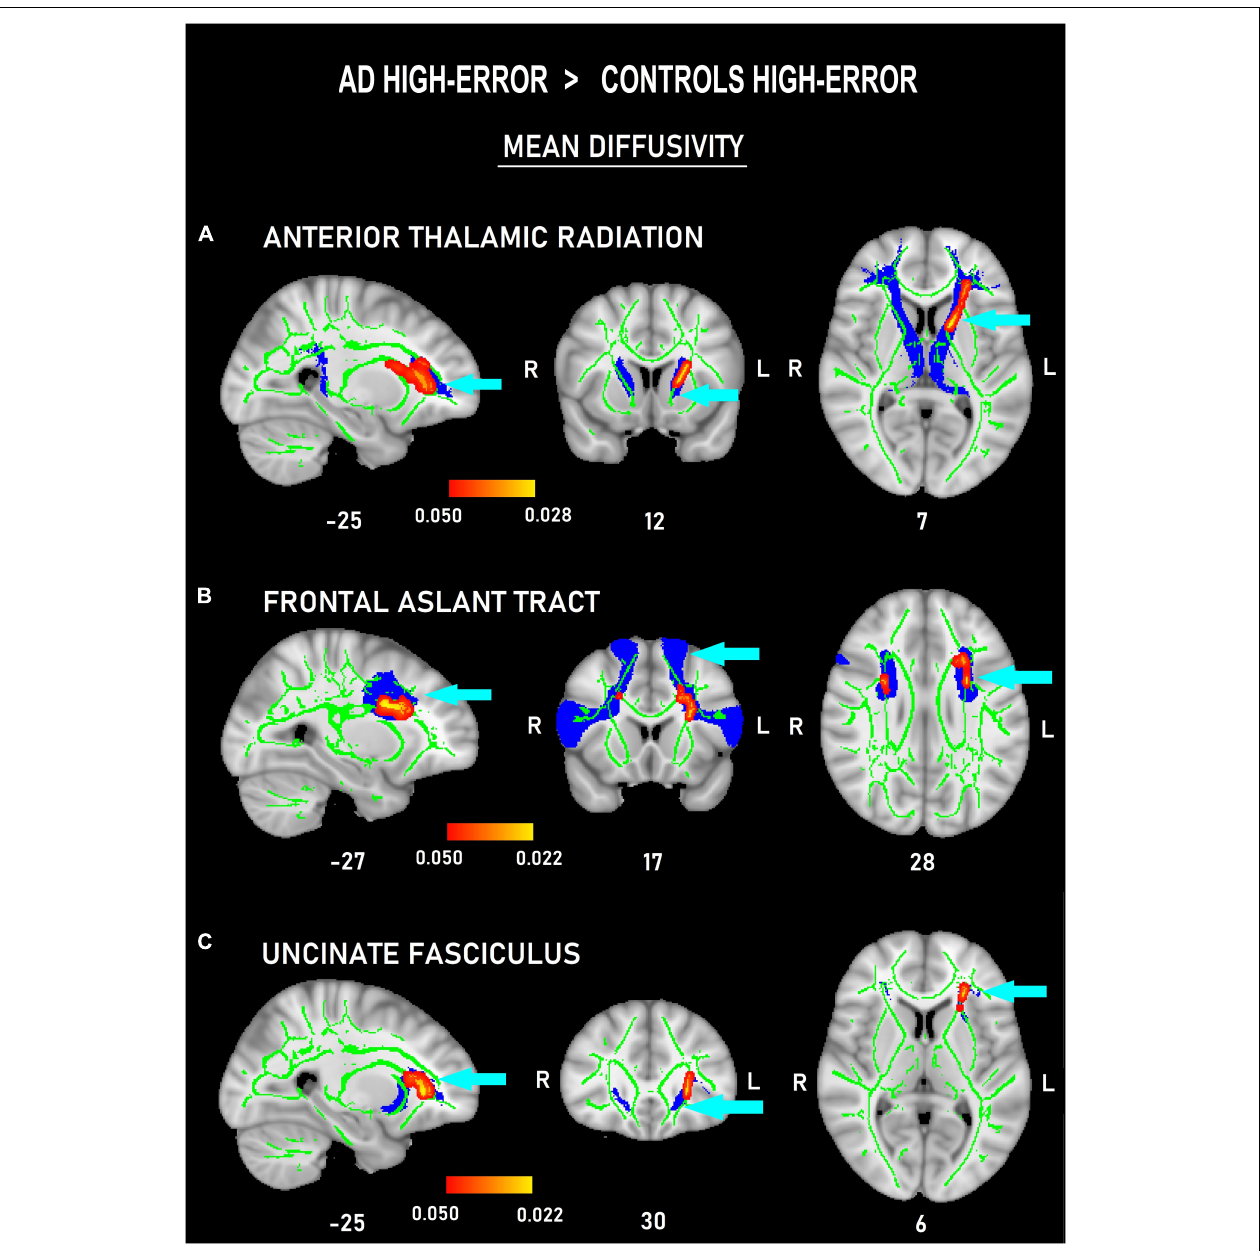
FIGURE 4 | Probability maps of tract-based spatial statistics showing clusters with increased mean diffusivity in patients with AD committing a high number of errors versus controls committing a high number of errors in three frontal white-matter tracts: anterior thalamic radiation (A) , frontal aslant tract (B) , and uncinate (C) fasciculus. Sagittal (left) , coronal (middle) , and axial (right) radiological views with corresponding MNI coordinates. Red-yellow shade bars indicate the significant p value ranges for every tract. The fractional anisotropy skeleton is shown in green. The area corresponding to each tract is shown in